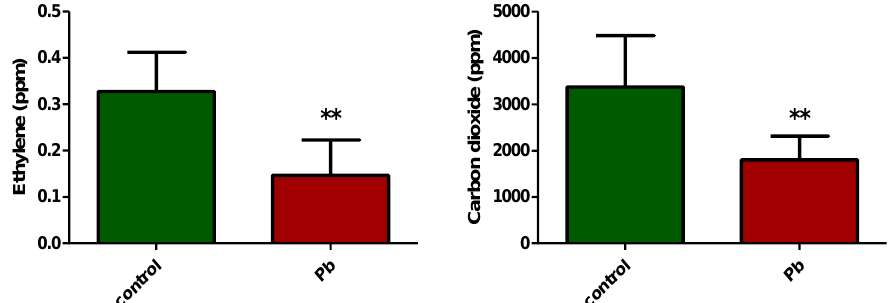
Figure 1. Ethylene and carbon dioxide production for common wheat seeds (Triticum Aestivum) germinated in normal (control) conditions or exposed to Pb. * p < 0.05, ** p < 0.01, *** p < 0.001 for unpaired t-test with Welch’s correction.